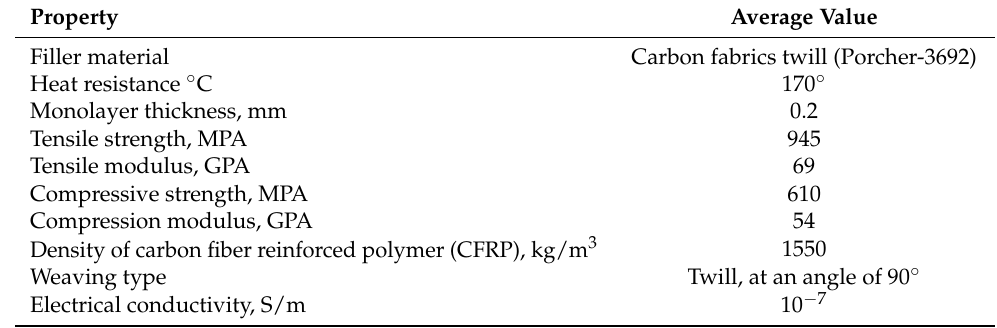
Table 1. Properties of polymer composite material (PCM).